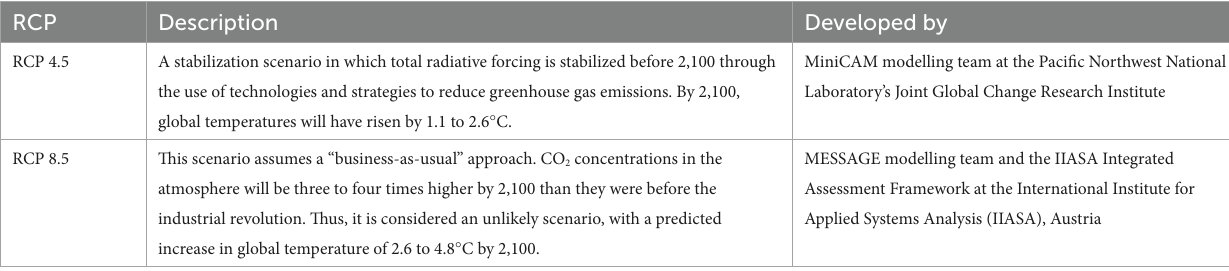
TABLE 1 Description of representative concentration pathway (RCP)